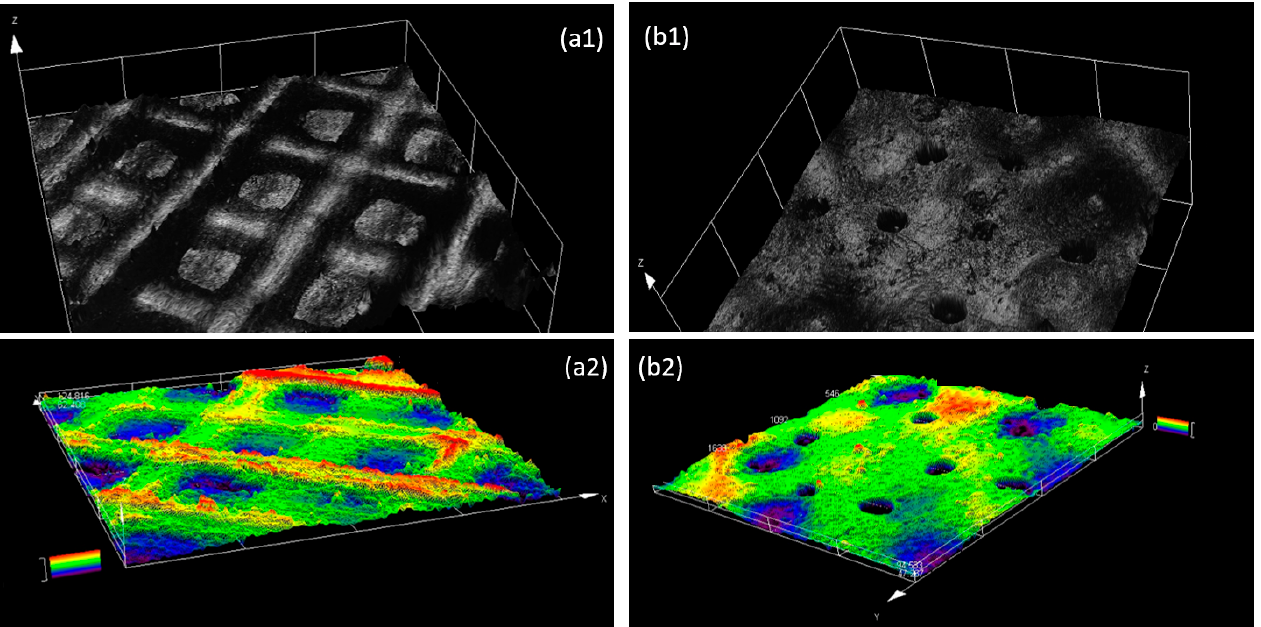
Figure 1. Laser scanning microscopy images of the 3D-printed membrane. Configuration of the sur- face and height profile of the side with large pores ( a1 , a2 ) and the side with a small pore size ( b1 , b2 ). In the membrane designed for GTR application, a membrane including 6 layers with a gradient structure, different pore sizes on different sides, and a total thickness of 150 µ m possessed the static tensile modules of 1.95 ± 0.55 MPa and dynamic tensile storage modulus of 314 ± 50 kPa [10]. One side of the membrane had large pores, ranging in size from 400 to 500 µ m (2 layers), while the other side had smaller pores, ranging in size from 50 to 150 µ m (2 layers). The two layers in the middle of the membrane have a pore size in the range of 200 to 300 150 µ m. The in vitro tests showed that the construct can perform the barrier function of a GTR membrane by separating two different cell types (epithelial and connective tissue cells) [10]. The membrane has suitable flexibility to be adapted to the in vivo study (Figure